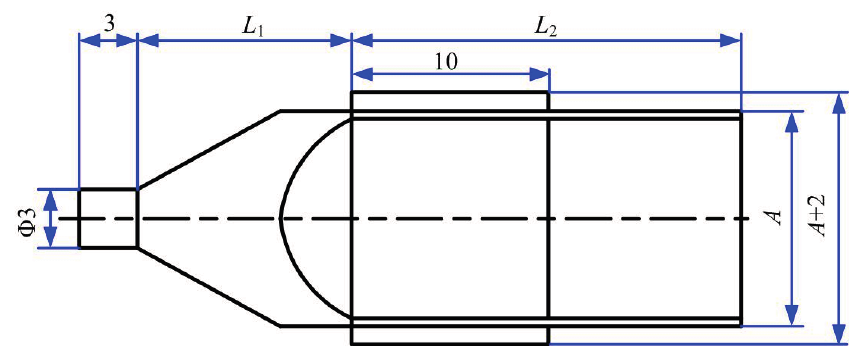
Figure 3. Main dimensions of the bending transducer (unit: mm).